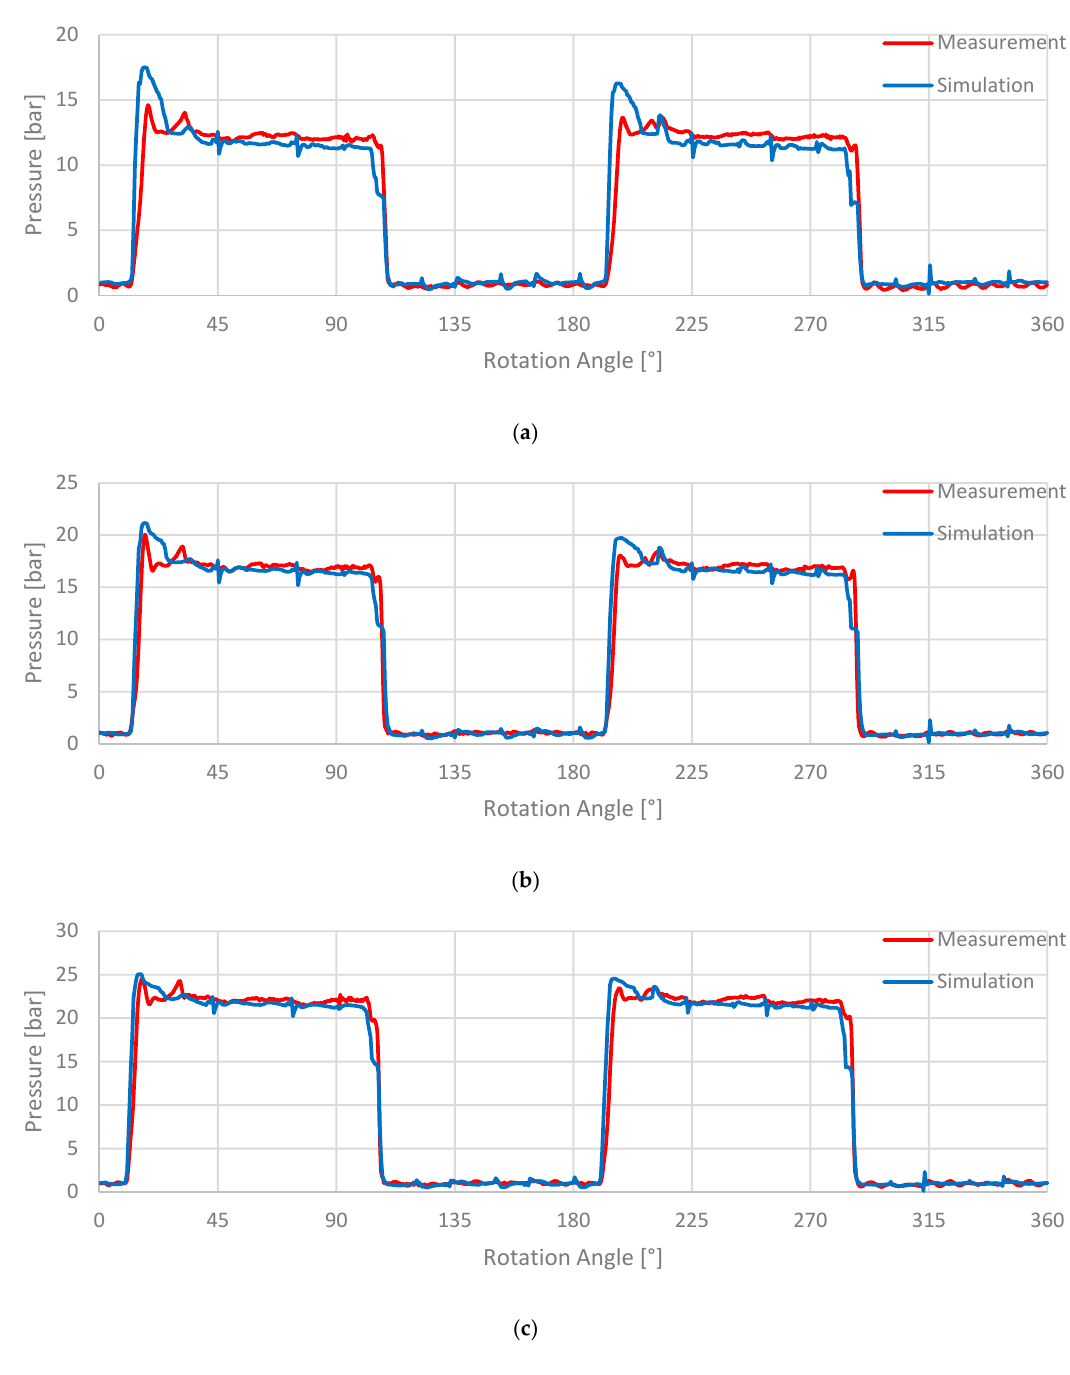
Figure 15. Comparison of measurement and simulation at a constant rotational speed of 2000 rpm at different delivery pressures ( a ) 10 bar; ( b ) 15 bar; ( c ) 20 bar.